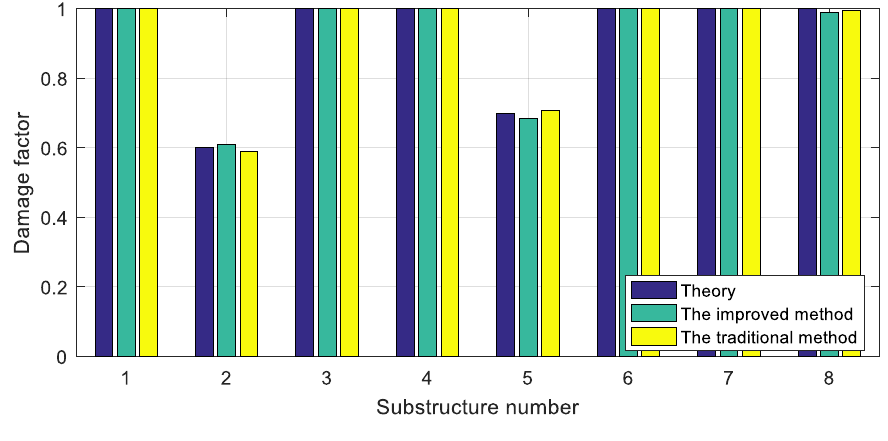
Figure 6. The identified damage extent. Table 3. Comparison of damage identification results using the improved objective function and traditional objective function.